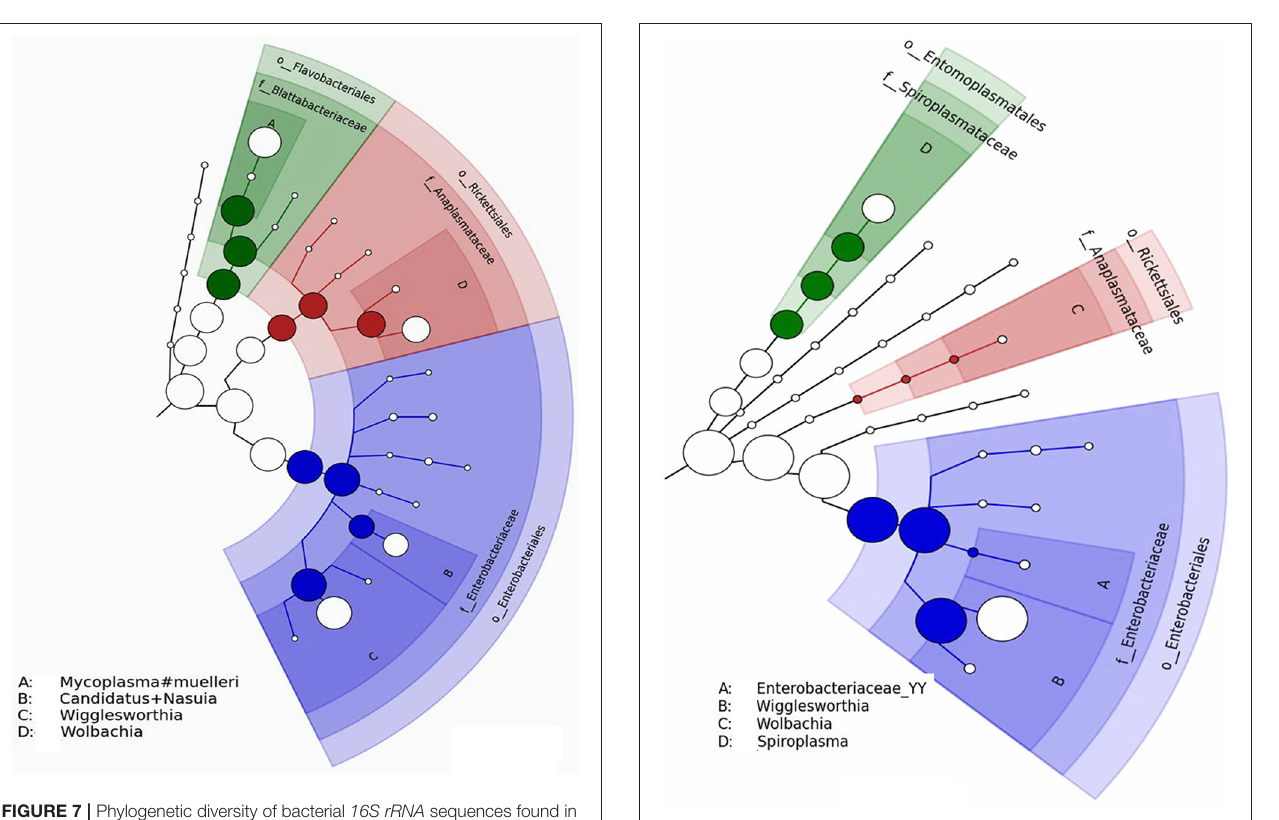
FIGURE 8 | Phylogenetic diversity of bacterial 16S rRNA sequences found in sample 30 (uninfected tsetse fly midguts from